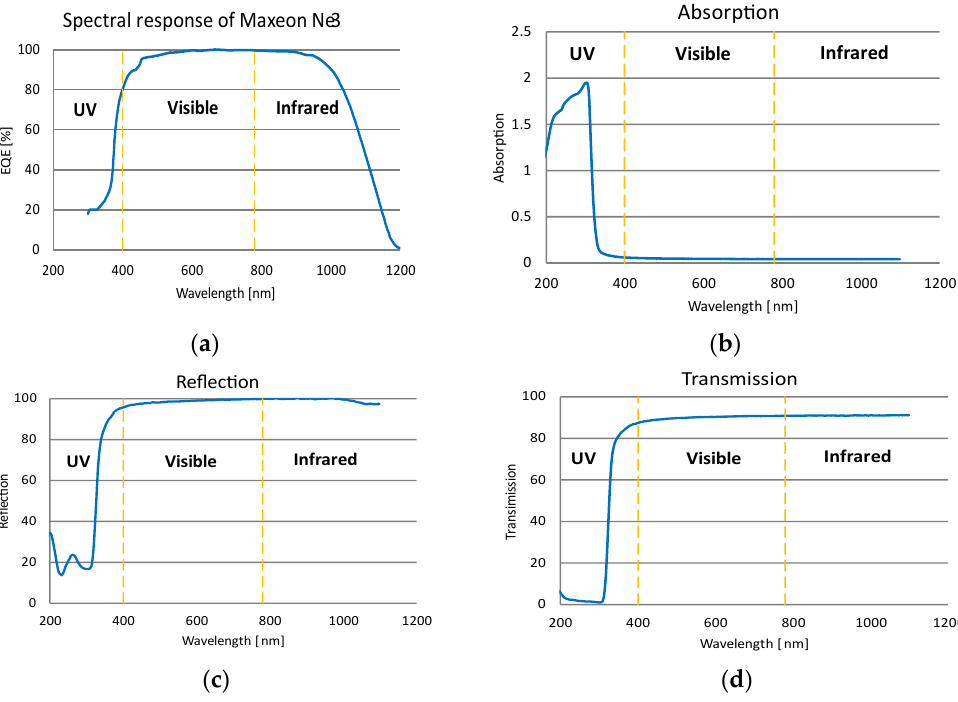
Figure 5. Characteristics of: ( a ) spectral response of Maxeon Ne3; ( b ) 100 μm film absorption; ( c ) 100 μm film reflection; ( d ) 100 μm film transmission.